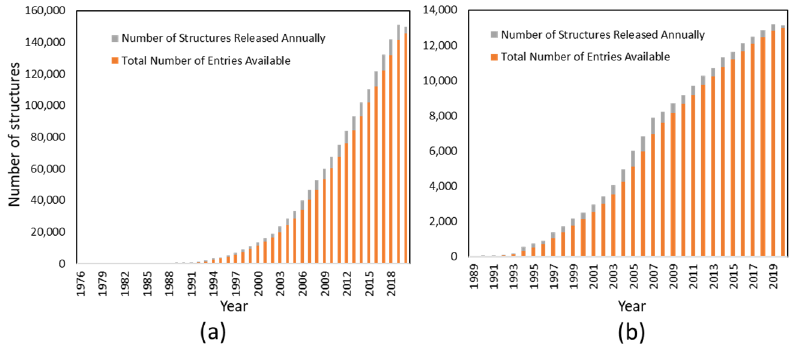
Figure 2. Structures determined by X-ray ( a ) and NMR ( b ) by year. The number of protein structures deposited in the Protein Data Bank (PDB) is plotted against year as of May 2020. The information was obtained from the PDB (https://www.rcsb.org/stats).